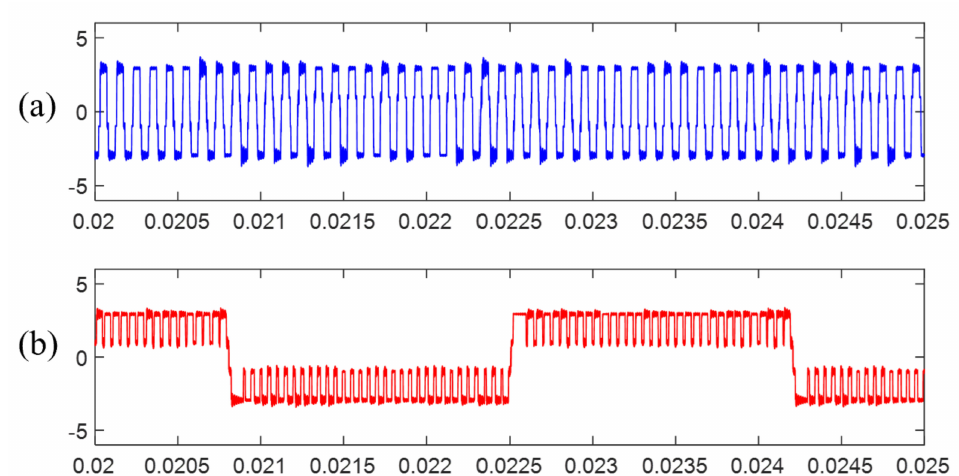
Figure 12. Comparison of shaft voltages with SVPWM and TSPWM in low modulation region (M = 0.2), respectively: ( a ) SVPWM, ( b ) TSPWM.